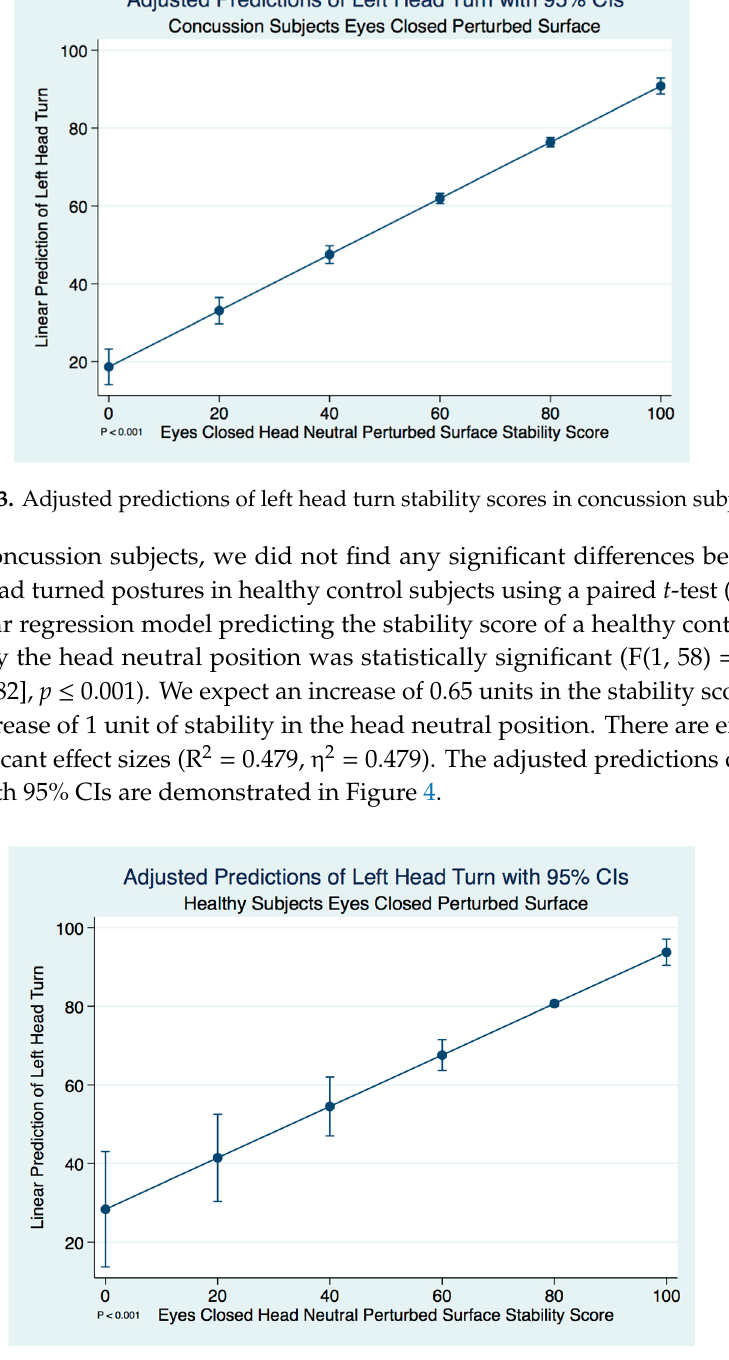
Figure 5. Adjusted predictions of head flexion stability scores in concussion subjects. Unlike the concussion subjects, we did find significant differences between the head neutral and head flexed postures in healthy control subjects using a paired t -test ( t (59) = − 3.247, p = 0.002). A linear regression model predicting the stability score of a healthy control subject with a left head turn